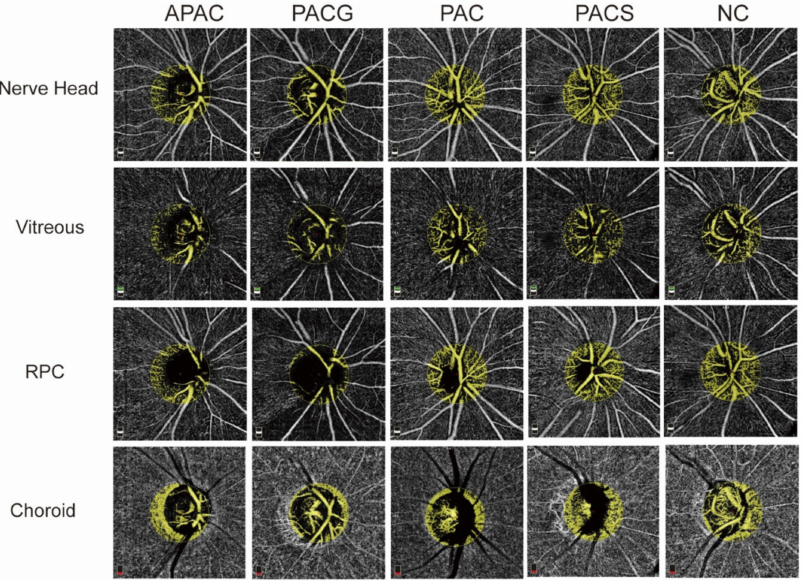
Figure 2. Image of the flow area (FA) of the optic disc. The FA was measured in the central 1 mm 2 area of the disc. PACG and APAC eyes show significantly a decreased FA in the nerve head, vitreous, and RPC layers.